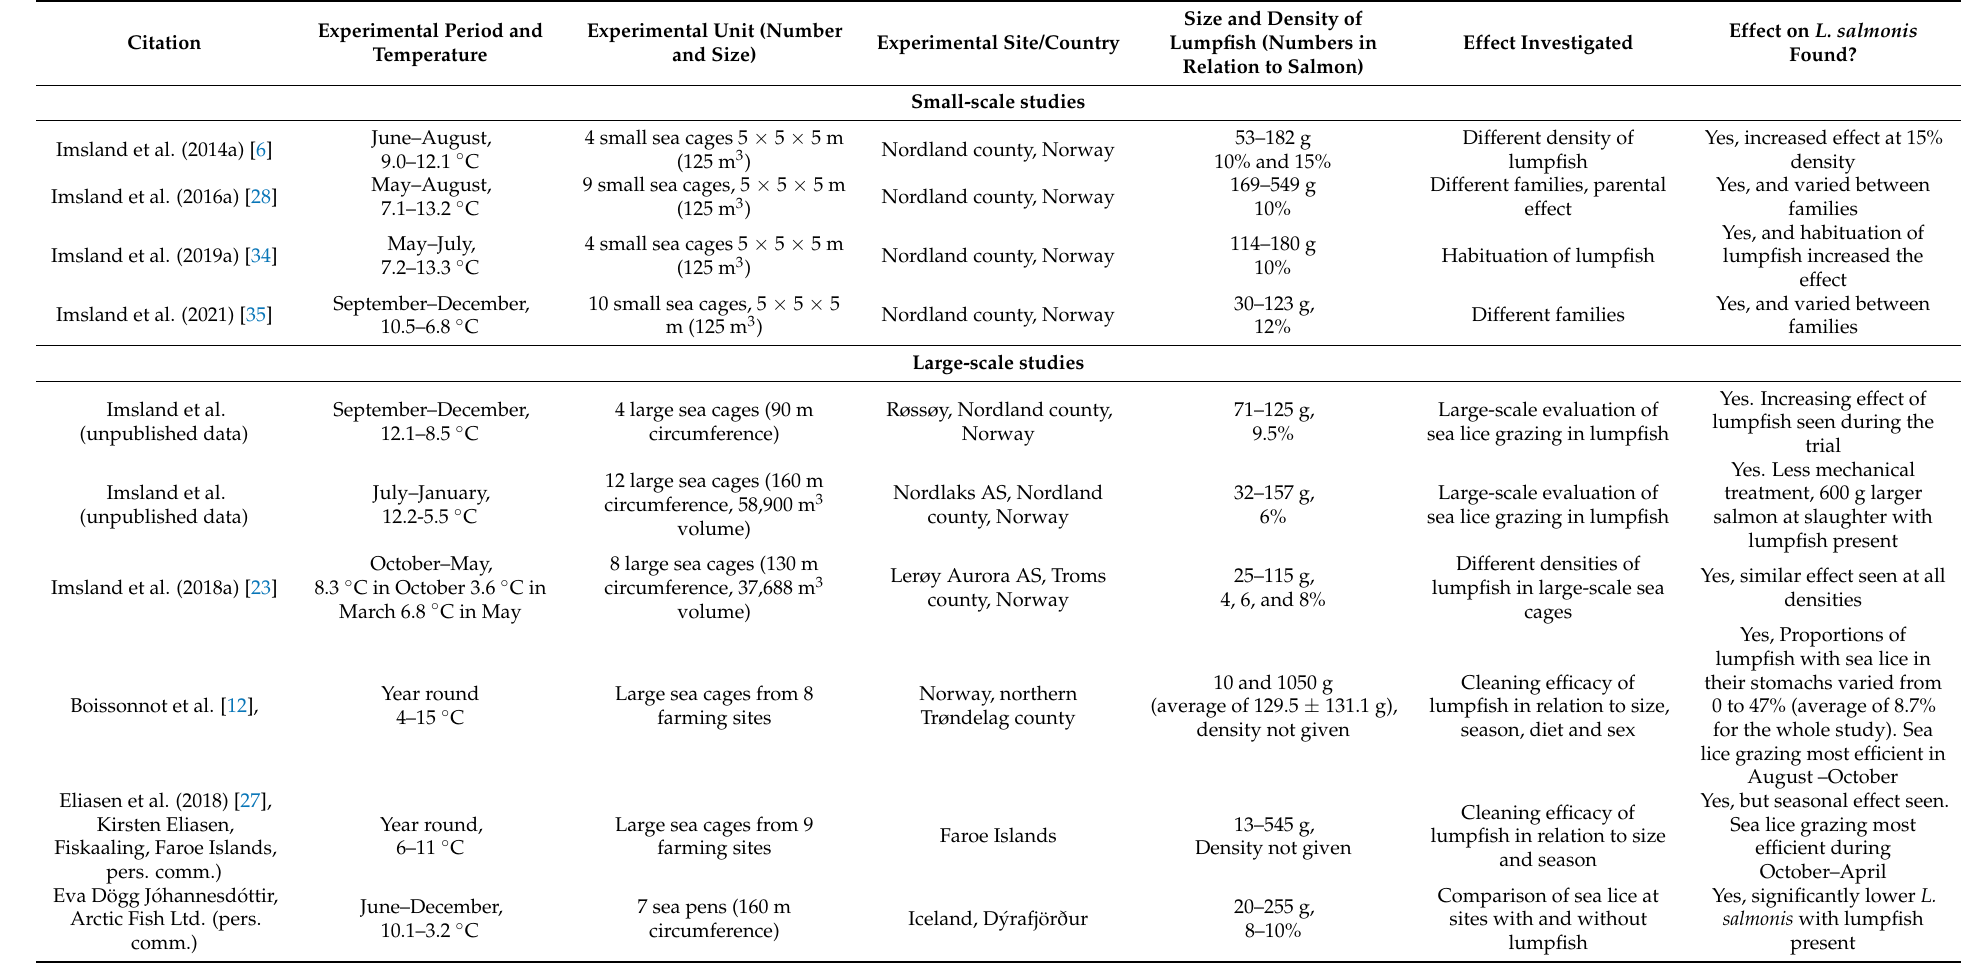
Table 1. A summary of the current literature (peer-reviewed journal articles and scientific reports) and observations (including pers. comm.) on experiments with lumpfish and their effect on L. salmonis infestations on farmed Atlantic salmon. Data include: experimental period and temperature, experimental unit, experimental site/country, stocking density of lumpfish, effect investigated, and whether an effect was